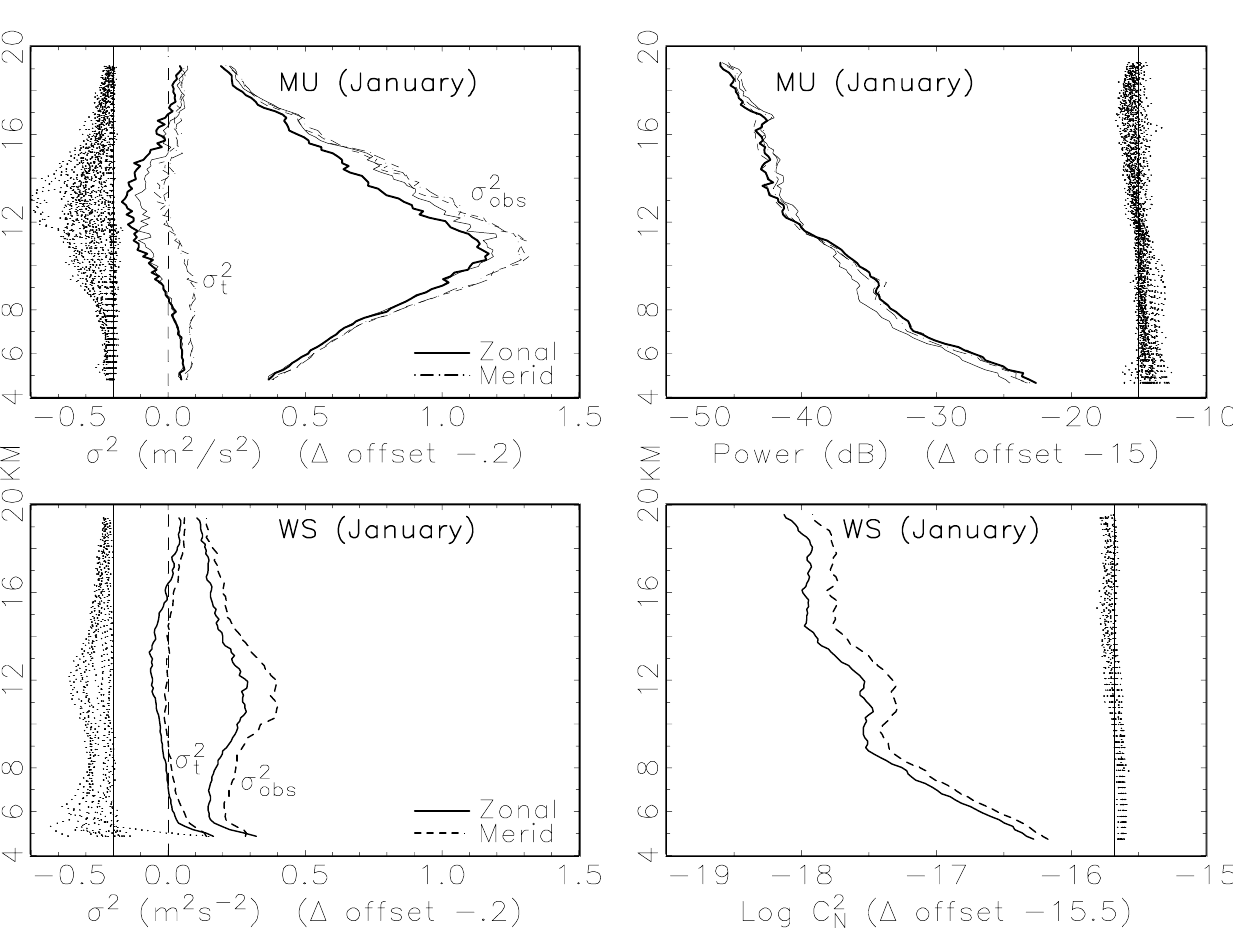
Fig. 1. Vertical profiles of the median spectral width (left) and returned power (right) for MU (upper) and WS (lower) during January. Solid (dashed) lines are for beams in the zonal (meridional) plane. Dotted lines show the differences in the values between the zonal and meridional